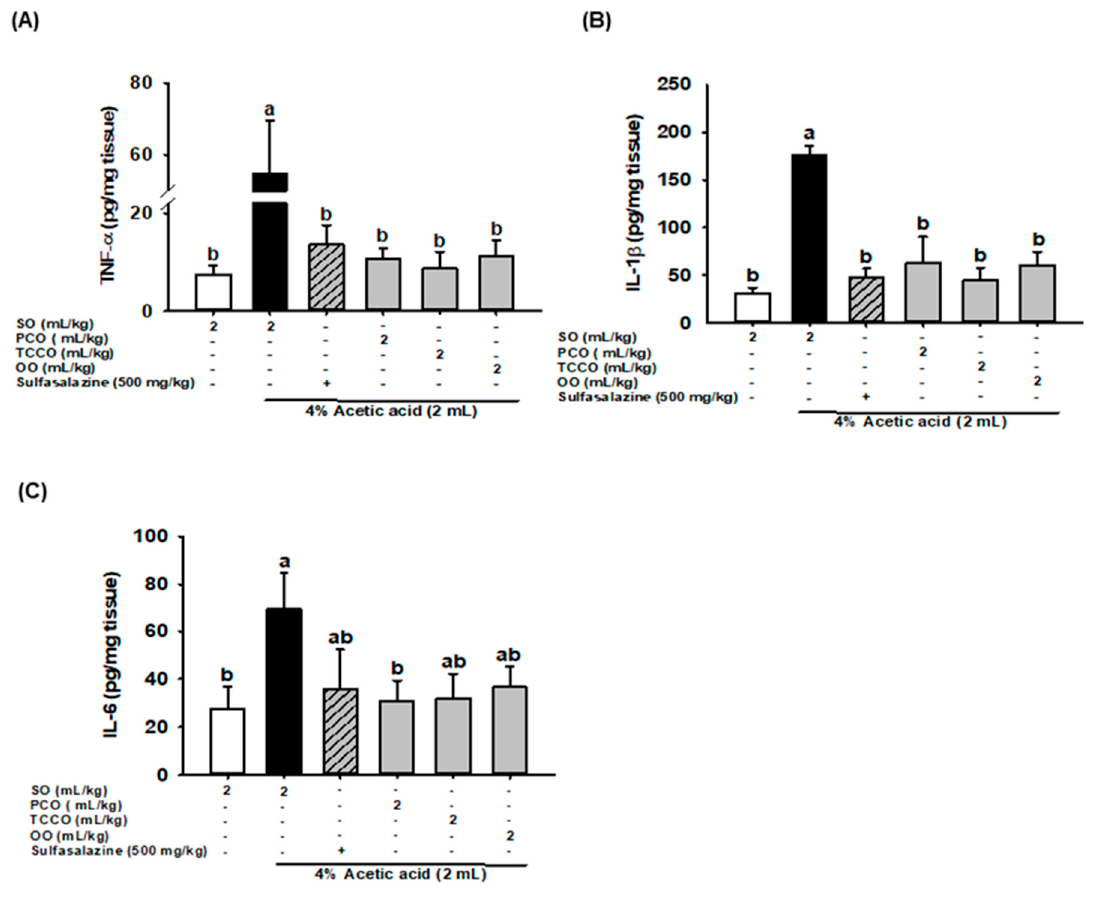
Figure 5. Effects of SO, PCO, TCCO, and OO on the levels of ( A ) TNF- α , ( B ) IL-1 β , and ( C ) IL-6 in the colonic mucosa of Sprague–Dawley rats with AA-induced colitis. The rats received oral administration of SO, PCO, TCCO, or OO for 3 weeks. Subsequently, AA was administered intrarectally for the induction of colitis (except in the normal control group). SASP was used as a positive control after colitis was induced using AA. + ( with SASP), − (without SASP). The rats were sacrificed on day 3, and their colon tissues were excised. The results are expressed as mean ± SEM ( n = 6). Values assigned different letters are significantly different at p < 0.05, which was determined using Duncan’s multiple range test. SO, 2 mL/kg body weight (BW) of soybean oil; AA, 2 mL of 4% of AA; SASP, 500 mg/kg BW of sulfasalazine; PCO, 2 mL/kg BW of C. oleifera oil; TCCO, 2 mL/kg BW of C. brevistyla oil; and OO, 2 mL/kg BW of olive oil.